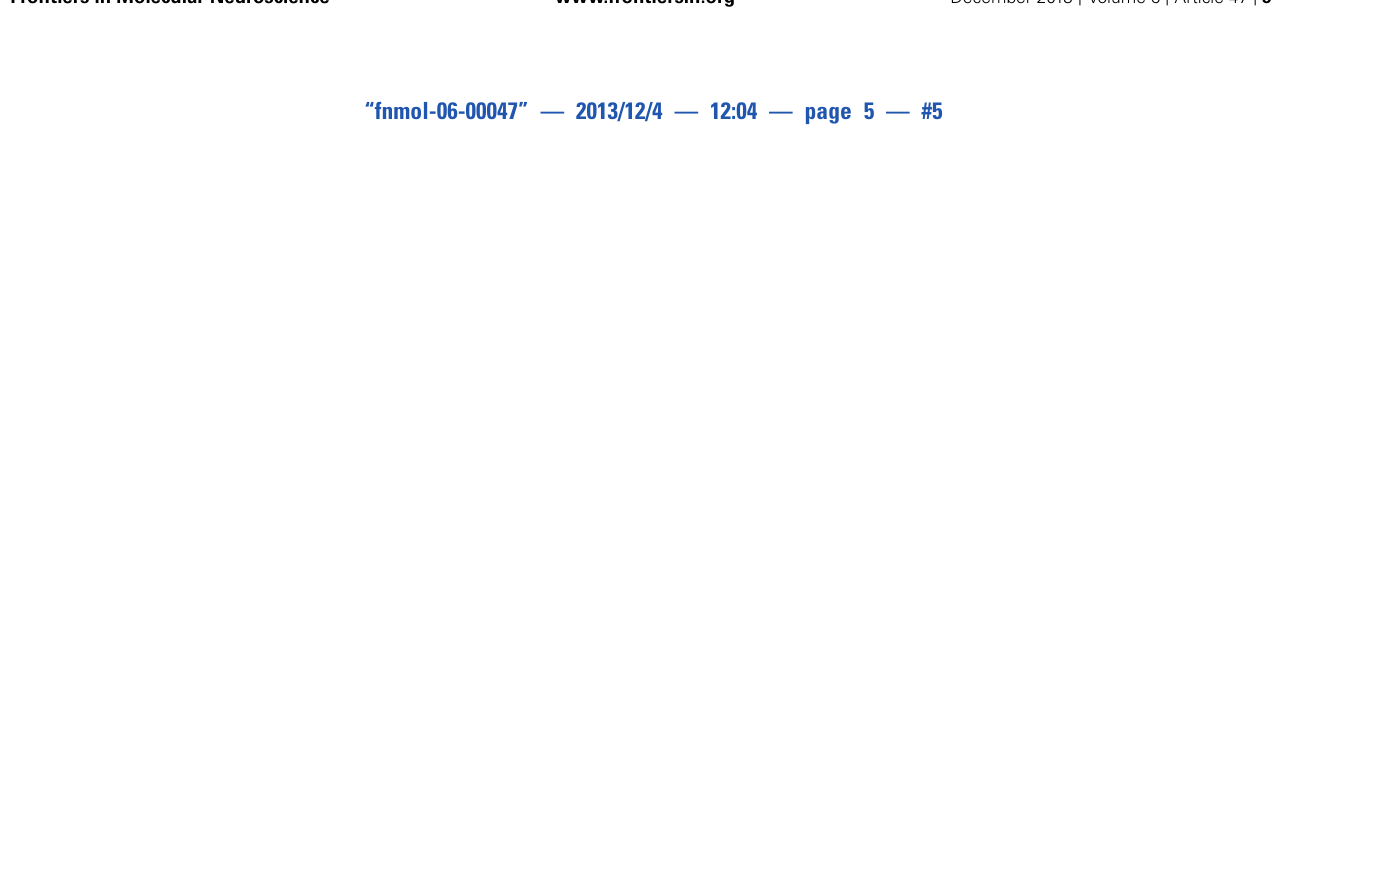
FIGURE 1 | Dysregulation of microRNA biogenesis in 22q11.2DS animal models. The MIR185 and the DGCR8 genes are located within the minimal 1.5 Mb microdeletion region on chromosome 22q11.2 and the equivalent region of mouse chromosome 16. The microdeletion leads to a hemizygosity of MIR185 and DGCR8 . The heterozygous Dgcr8 deficiency is responsible for the reduced biogenesis of a specific subset of microRNAs (red) observed in Df(16)A + / − mice (Stark etal., 2008). These down-regulated microRNAs include miR-185 (black). The pronounced